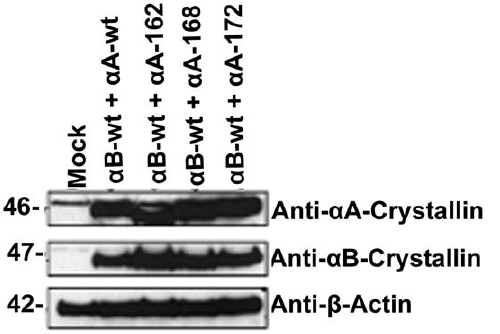
Figure 6. Level of expression of the various a A-crystallins when they were co-expressed with a Bwt. Western blotting was probed with anti- a B antibody and anti- a A antibody. The details are as in Fig. 2. The results validate the transfection efficiency of each of the pairing of a A and a B constructs is nearly equal. There is a non-specific immunoreactive band was observed in mock control cells, lane 1.